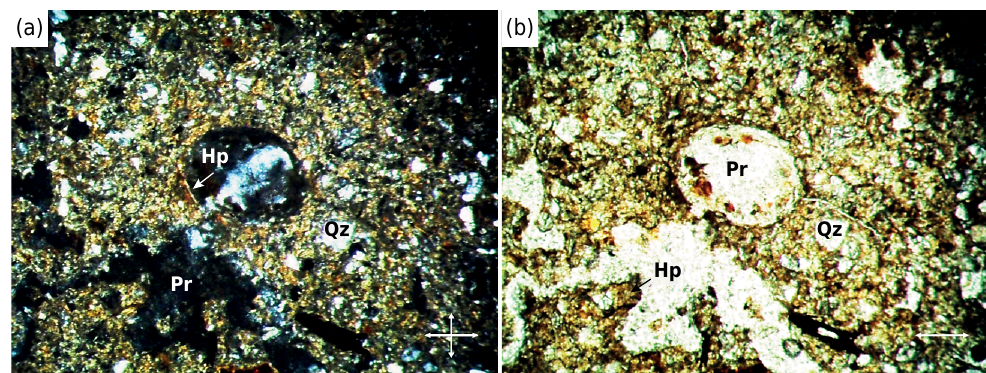
Figure 3. Photomicrographs images of 3Cvn layer in the Fluvisol [(a): cross-polarized light; (b): natural light]. Presence of irregular pores (Pr); quartz (Qz) in the course material and features of hypo-coating (Hp).